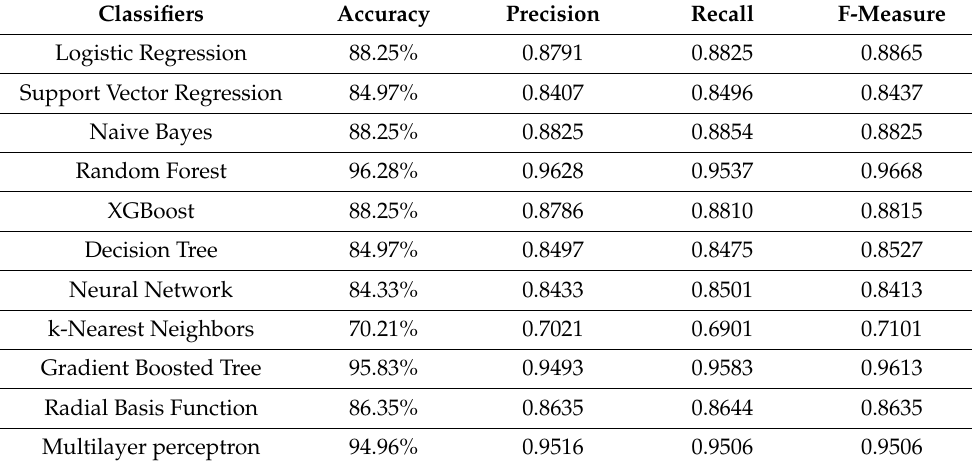
Table 4. Accuracy of ML